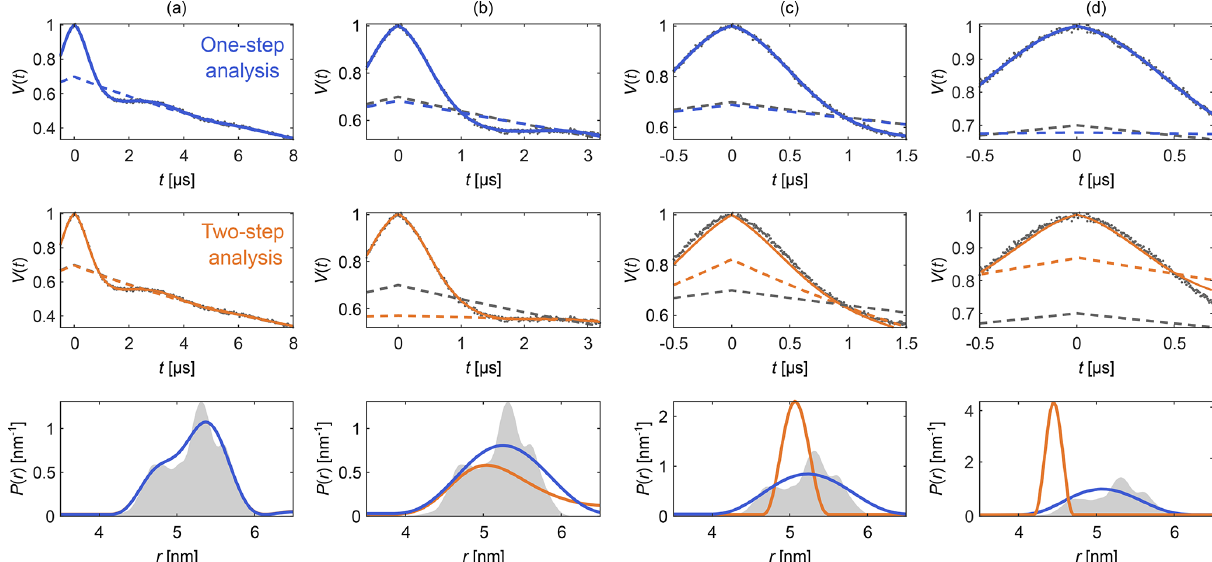
Figure 4. Comparison of one-step and two-step analysis. A stretched-exponential background and a non-parametric distance distribution were fit to a simulated four-pulse DEER signal. The analysis was done by either fitting both simultaneously (blue) or by fitting the background followed by the distribution (two-step analysis, orange). The analysis was repeated on the same signal with increasing truncation (a–d) . The two-step analysis fails in case (d) . The data are given as grey dots, and the fitted signal and background are given as solid and dashed colored lines, respectively. The true background is given as a grey dashed line for reference. The non-parametric distance distributions obtained via Tikhonov regularization are given as, respectively, colored lines and the ground truth as a shaded area.